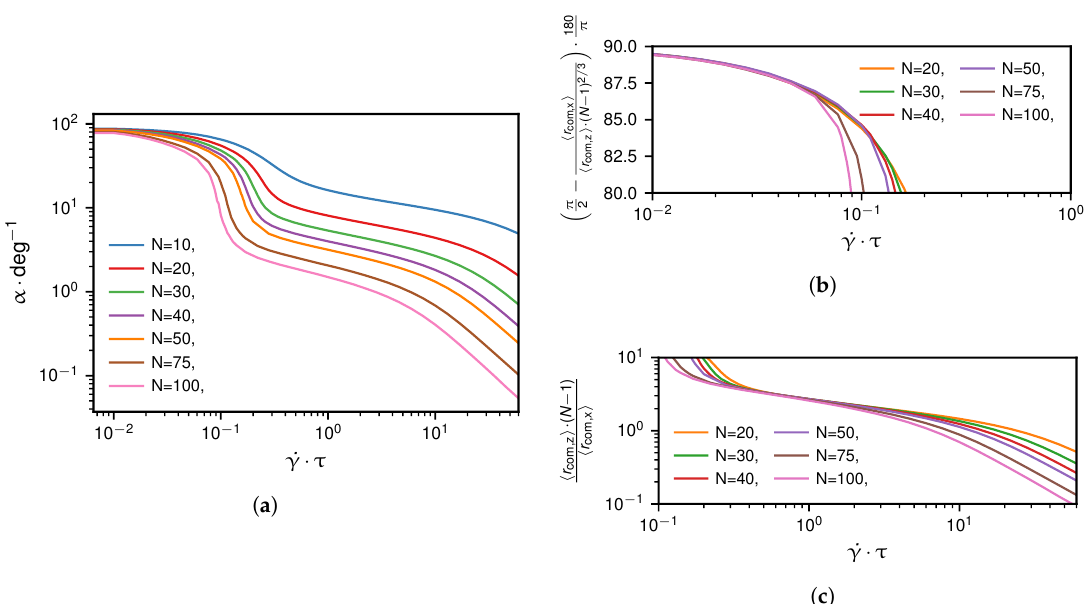
Figure 11. Grafted scenario: Subfigure ( a ) shows the dependence of the angle α , graphically defined in Figure 9c, on the chain length and on the shear rate. The scaling relations for the projections of the center of mass positions given by Equation (16) and (17) lead to the scaling of α below the critical shear rate, given by Equation (18) and shown in subfigure ( b ) and above the critical shear rate, given by Equation (19) and shown in subfigure ( c